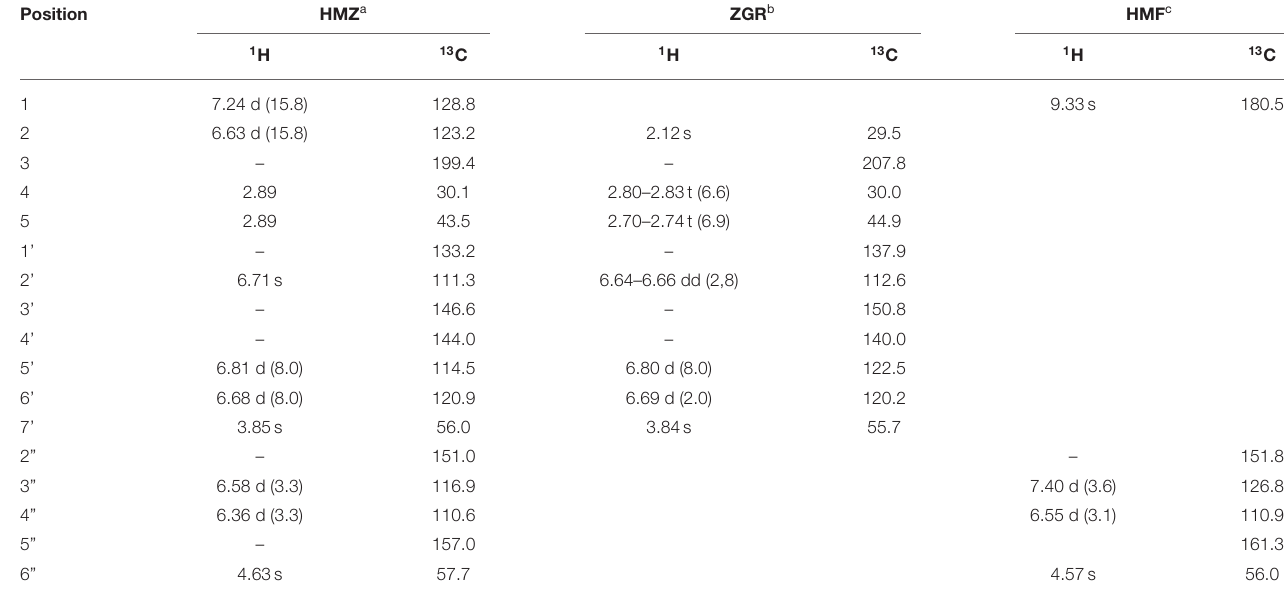
TABLE 1 | 1 H and 13 C NMR data of HMZ, ZGR, and HMF ( δ in ppm, J in Hz). Position